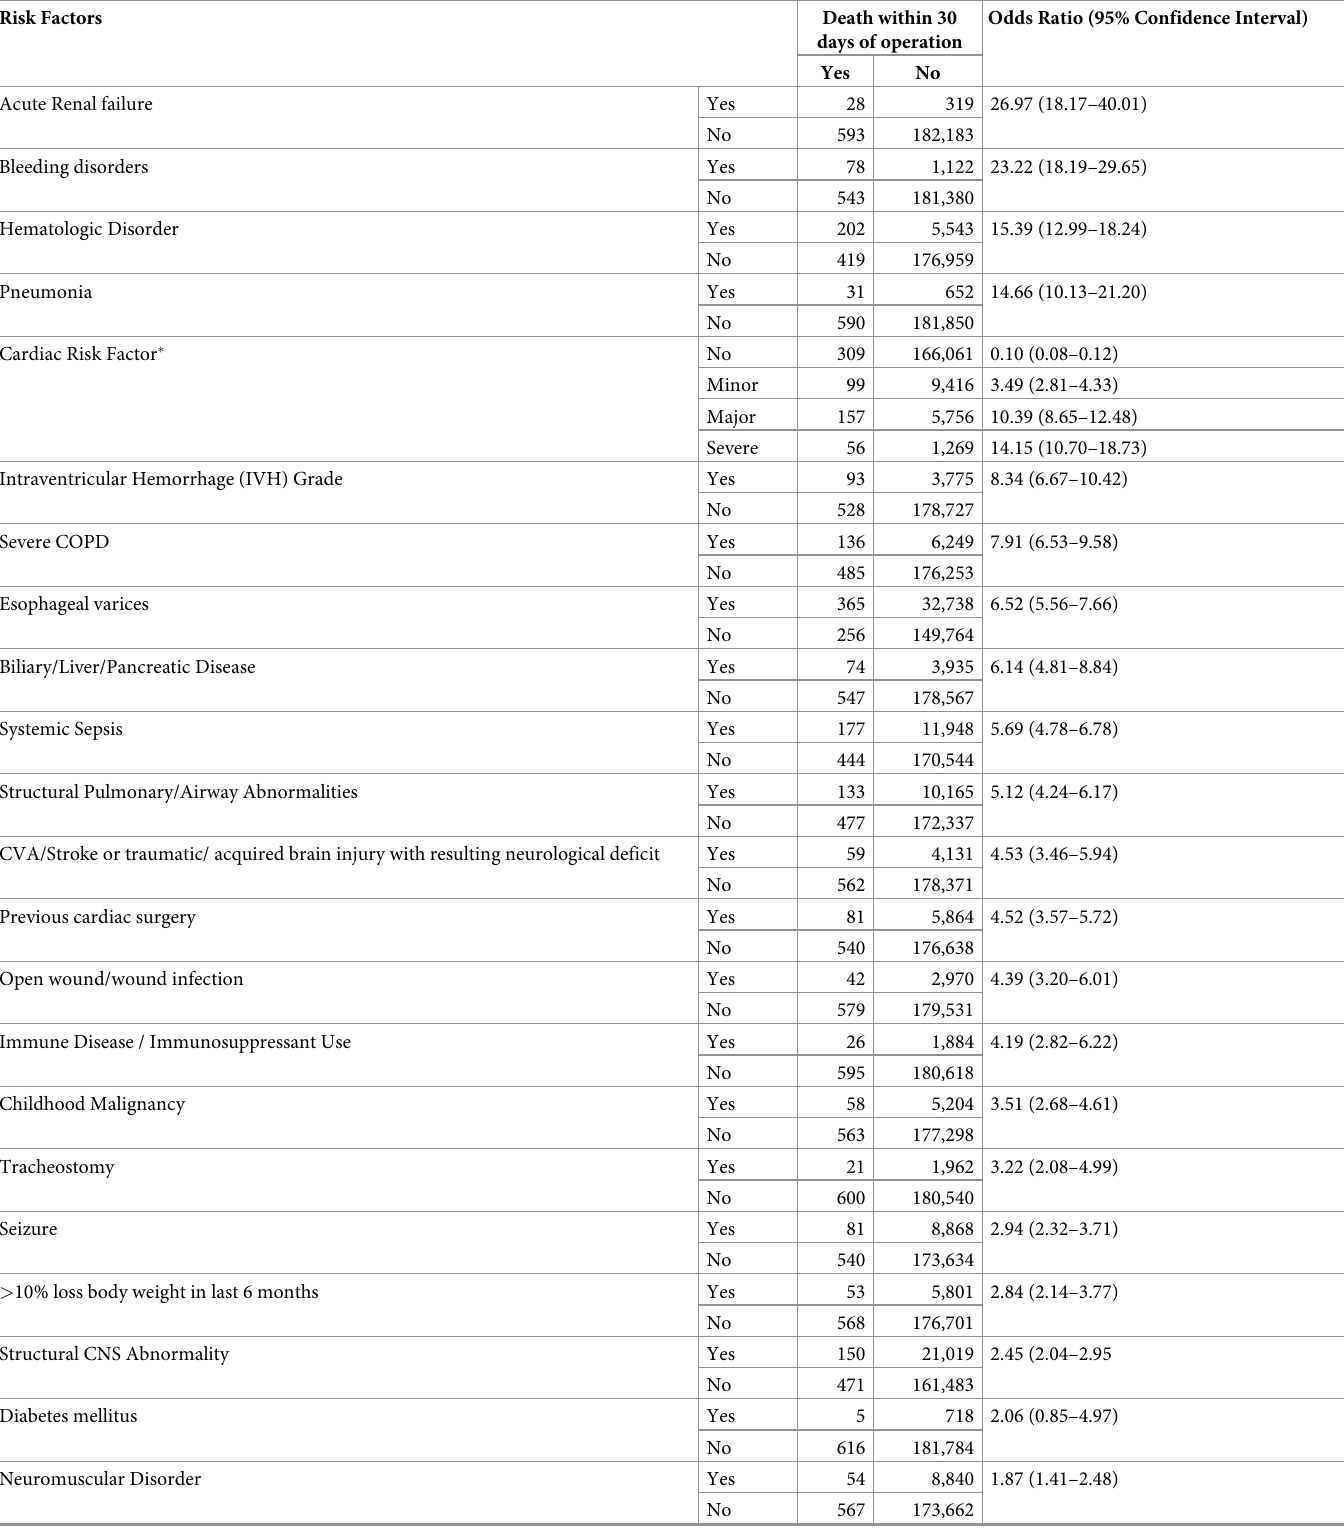
Table 2. Comorbidities and risk for death after